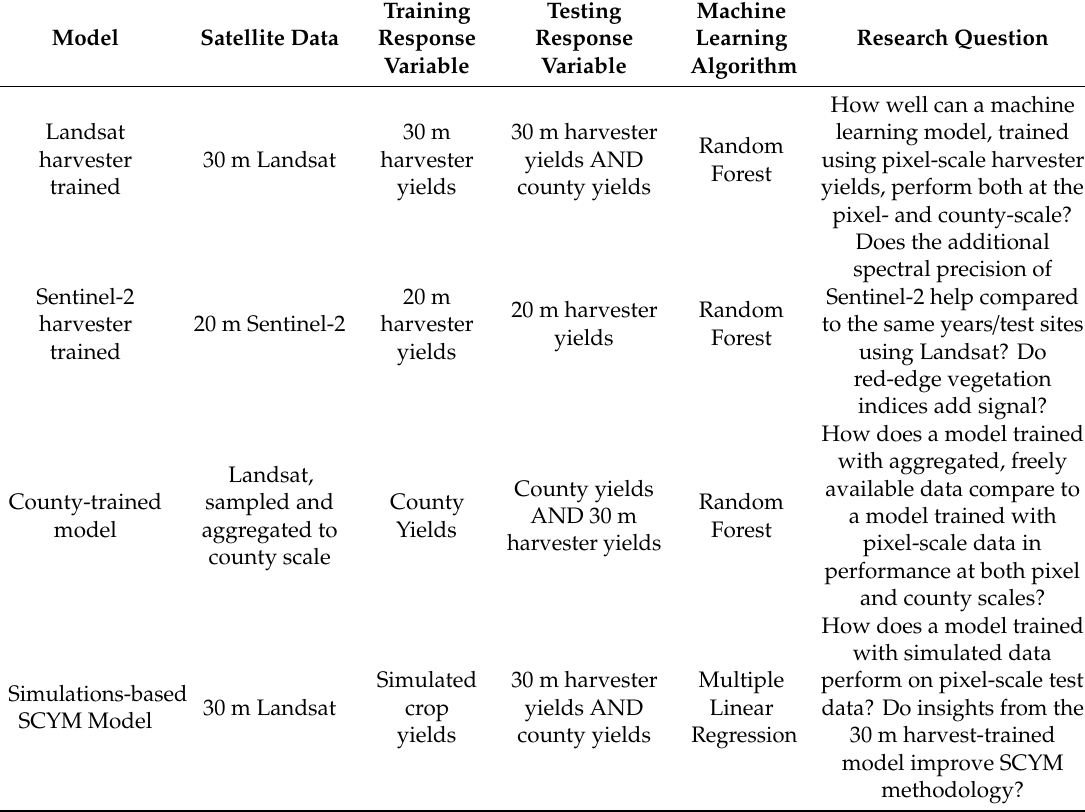
Table 1. Model definition and overview. The four main modeling approaches tested in the paper, presented in terms of their input satellite data, their training and testing response variables (pixel, county, or simulated yields) and the motivating research question for their exploration. “Harvester” in the first column refers to combine harvesters, from which our pixel yield data comes (Section 2.2). SCYM = Scalable Crop Yield Mapper (Section